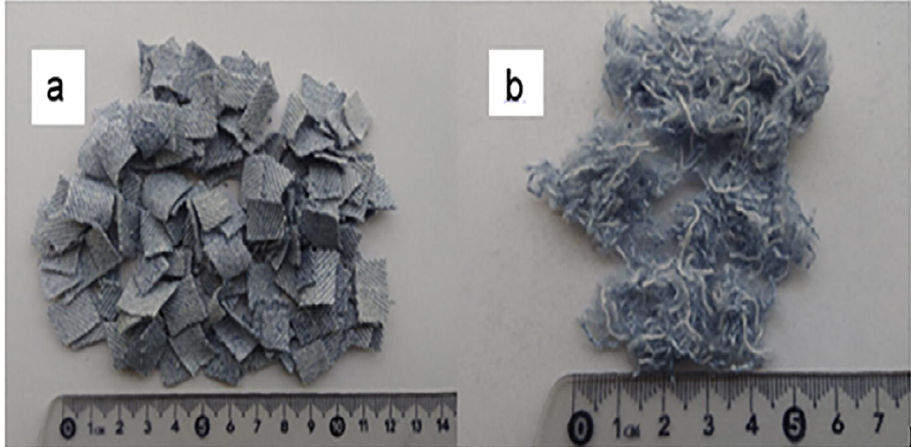
Figure 9. Textile waste can be used to improve some properties of concrete: ( a ) waste blue-jeans and ( b ) cotton fiber from blue-jeans. Reprinted with permission from [87]. Copyright© 2018, Elsevier B.V.